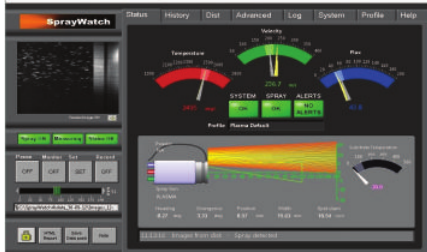
Figure 5: Particle velocity and temperature profile by CCD